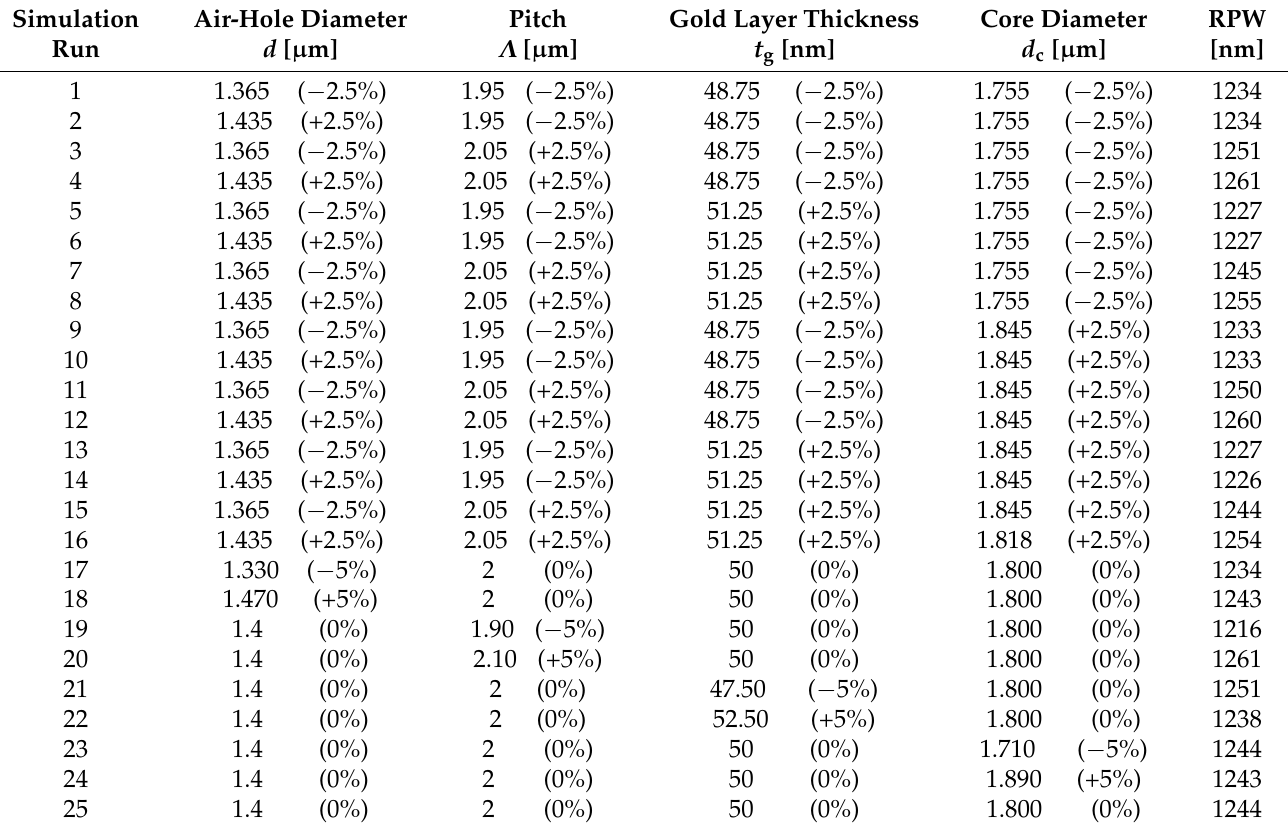
Table 7. FEM Simulations for Five-Level 4-Parameter ( ± 5% variations) CCD